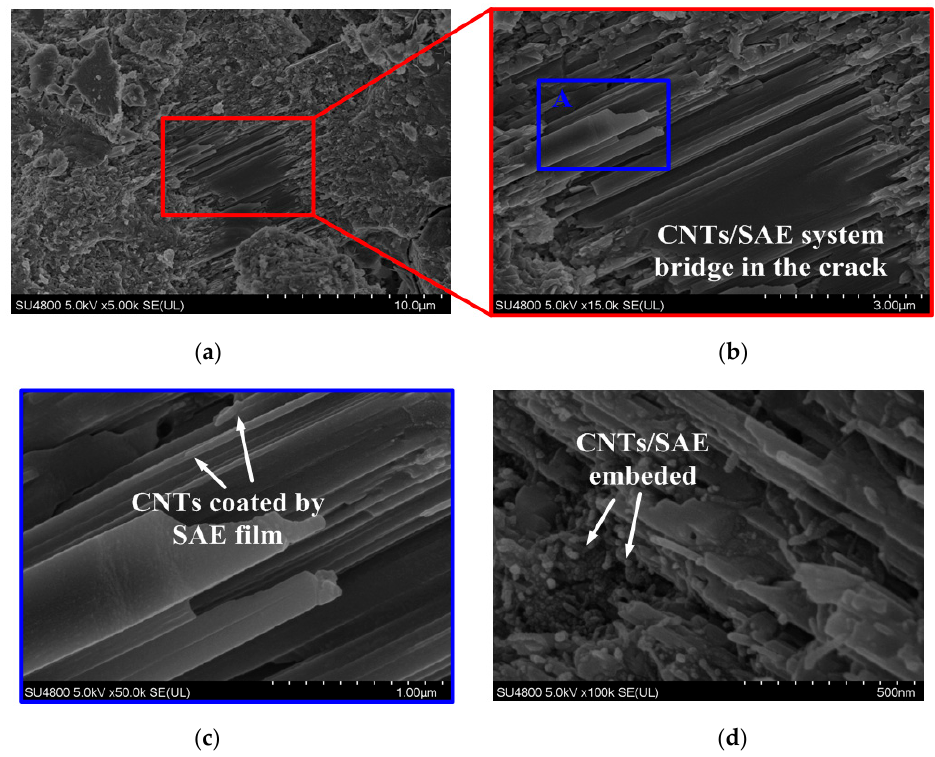
Figure 12. SEM micrographs of the ( a ) hardened HSPC; ( b ) magnified SEM image of the box region in (a); ( c ) magnification of point A in (b); and ( d ) CNTs/SAE embedded in the hydration products (for 28 days).